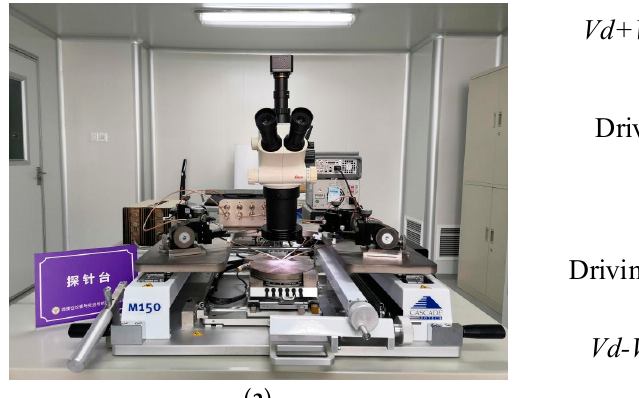
Figure 6. Photographs of the fabricated accelerometer. With the help of the probe station (Figure 7a), an open-loop test of the accelerometer was conducted. The outer fixed combs of the upper resonant beam and the inner fixed combs of the lower resonant beam are the driving end, and the opposite is the detection end. The two sides of the resonator are connected with a DC biased AC driving voltage to drive the resonator to the reverse working mode. The common terminal current is drawn at the anchor. The test leads are shown in Figure 7b.